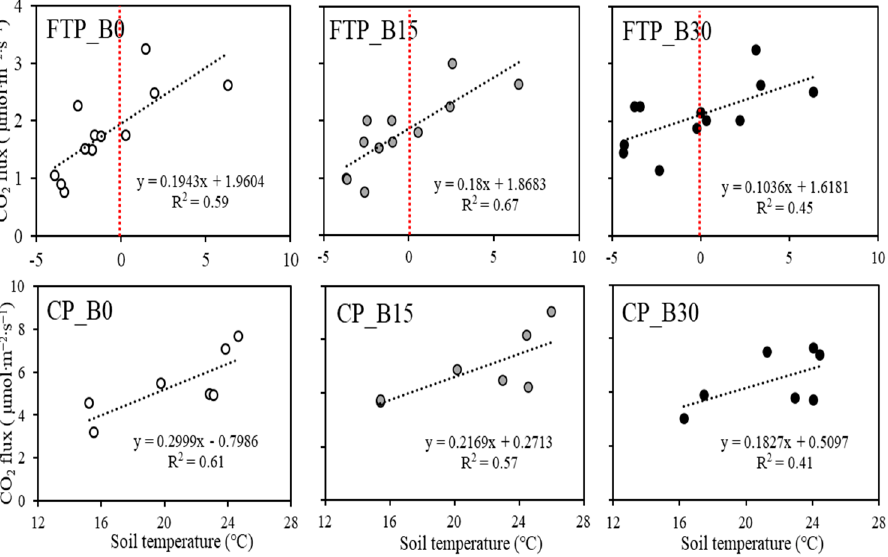
Figure 5. Relationship between soil respiration rate and soil temperature for different biochar addi- tions.